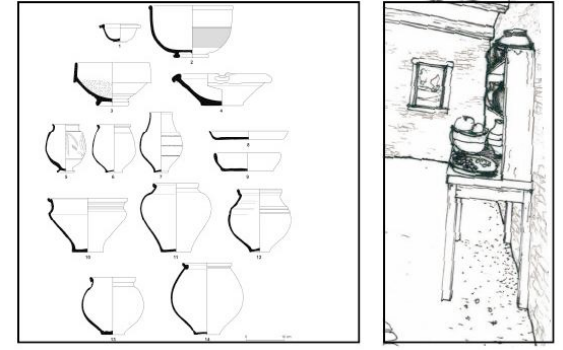
Figure 4. Ex-situ element reconstruction